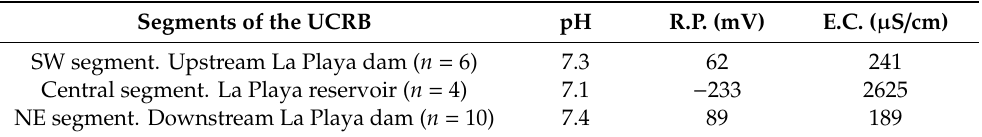
Table 5. Physicochemical properties of the UCRB sediments. R.P.: Redox potential. E.C.: Electrical conductivity. Physicochemical properties of the waters are available in the Supplementary Materials (Table